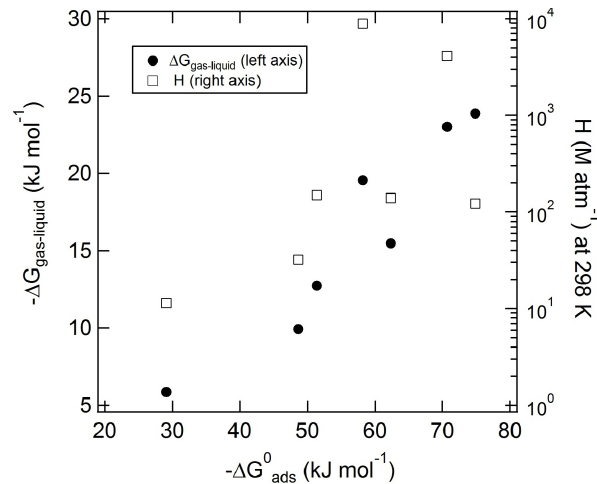
Fig. 2. Summary of standard Gibbs free energy of adsorption